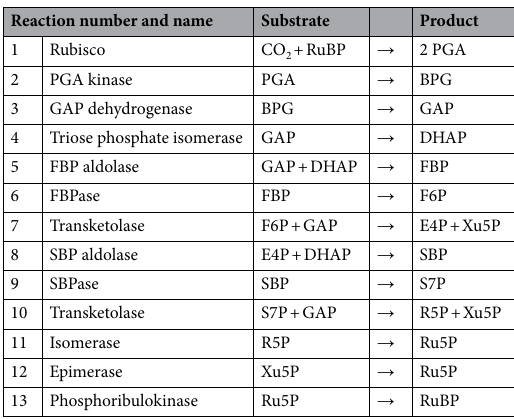
Reaction number and